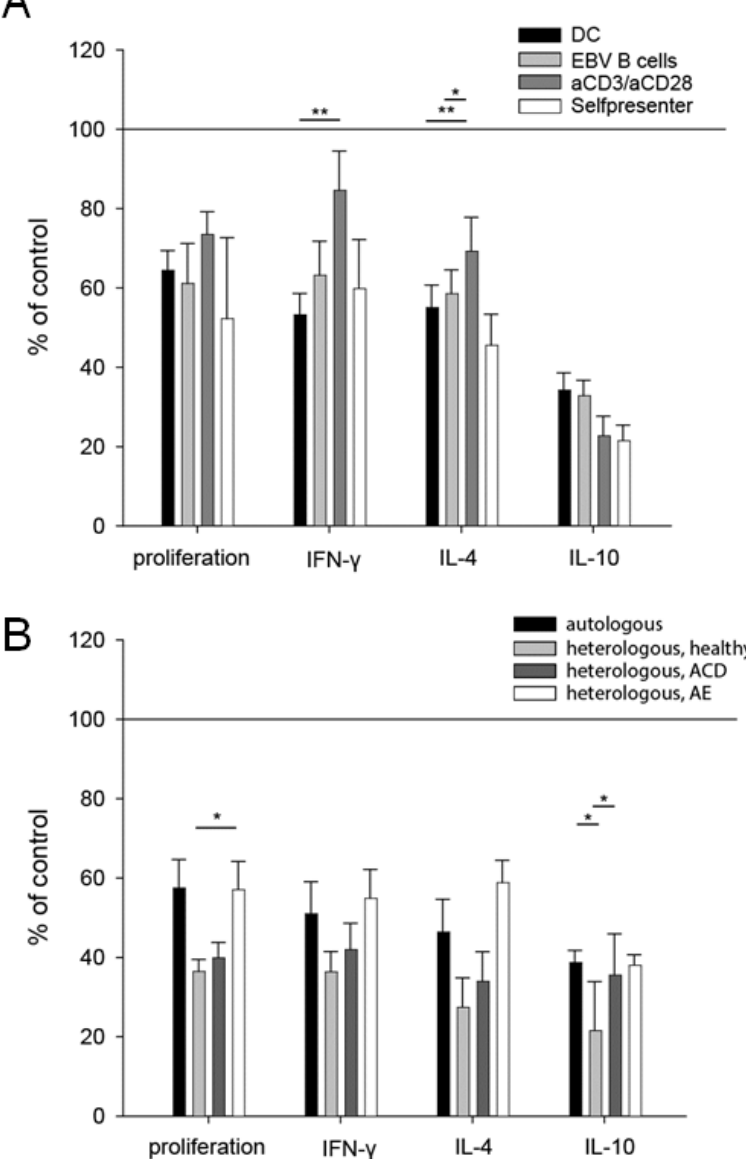
Figure 4. The inhibitory capacity of keratinocytes is independent of the antigen presentation and HLA-TCR interactions. Nickel-specific T cell clones were co-cultured with autologous keratinocytes, nickel sulfate and different types of APCs (dendritic cells (DC), Epstein–Barr-virus-transfected B cells (EBV B cells)), TCR stimuli (anti-CD3/anti-CD28 antibodies) or in the absence of professional APCs as self-presenter cells (self) ( A ). Comparison of the co-culture of nickel-specific T cells, DCs, nickel sulfate and autologous keratinocytes to the co-culture with heterologous keratinocytes ( B ). The heterologous keratinocytes were obtained from a healthy volunteer, a patient with ACD to nickel and one patient with atopic eczema/dermatitis (AE). All conditions showed significant differences, compared to the control condition (set to 100%) ( p < 0.05). Results were analyzed using one-way ANOVA with Tukey correction for multiple testing. (( A ) DC clones = 13, n = 50; EBV clones 20, n = 53; aCD3/aCD28 clones 8, n = 25; self-presenter clones 8, n = 33; ( B ) autologous n = 35; heterologous healthy n = 10; heterologous ACD n = 22; heterologous AE n = 8); *: p < 0.05; **: p <